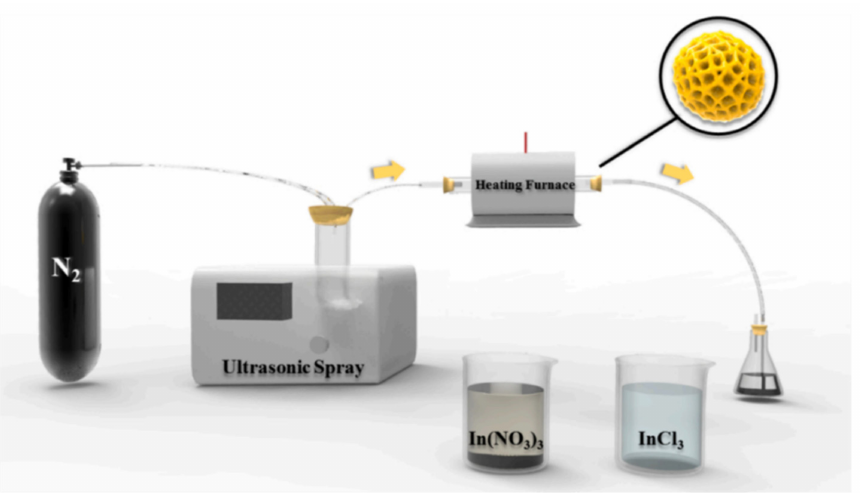
Figure 28. Schematic representation of the experimental procedure followed to fabricate ultrasonic pyrolysis spray-based wrinkled microspheres. Reproduced with permission from reference [115]. Copyright 2021, Elsevier